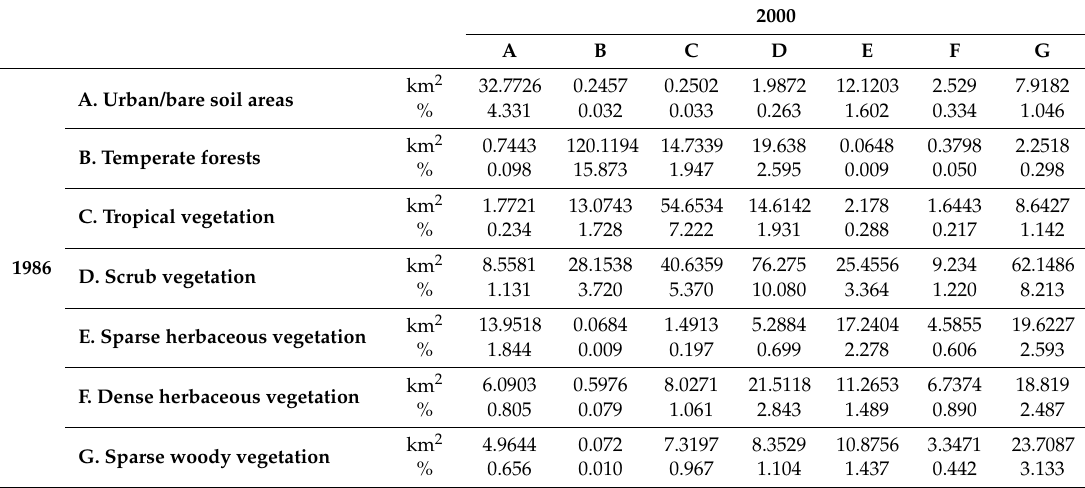
Table 12. Matrix of land use-cover changes from 1986 to 2000, in the adjacent area of Natural Protected Area Altas Cumbres (NPAAC). Victoria, Tamaulipas, Mexico.